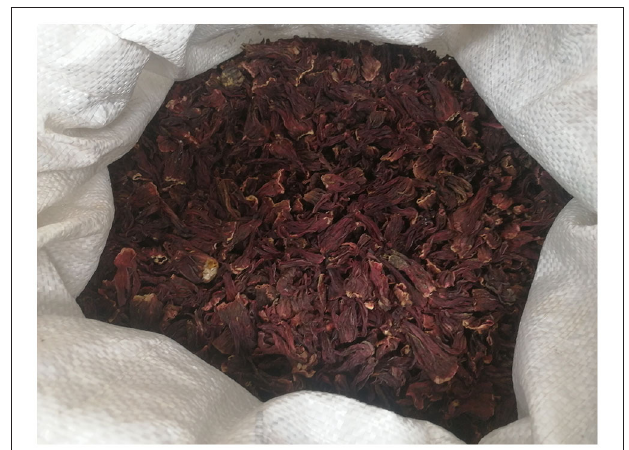
FIGURE 1 | Dried H. sabdariffa